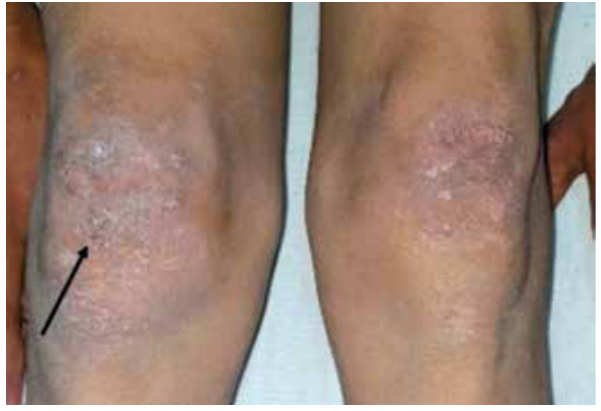
Fig 3. Violaceous plaque over both knees